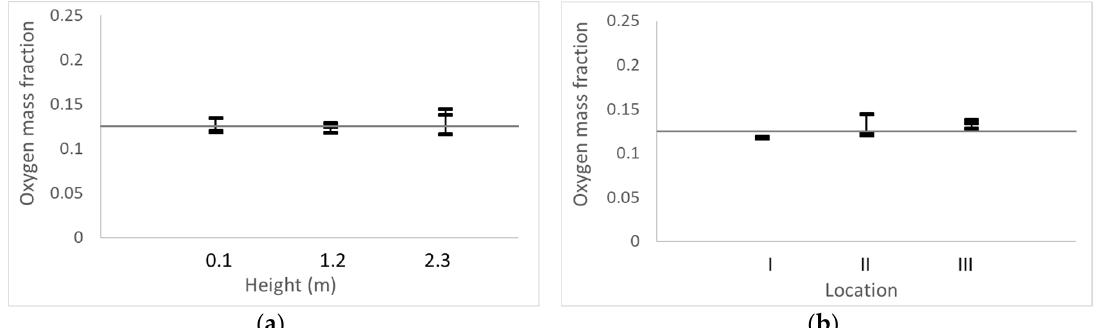
Figure 5. The lowest, median, and highest oxygen mass fraction at height 0.1, 1.2, and 2.3 m above the floor ( a ), and at locations I, II, and III at 100 s for case C0_100_1.0 ( b ).